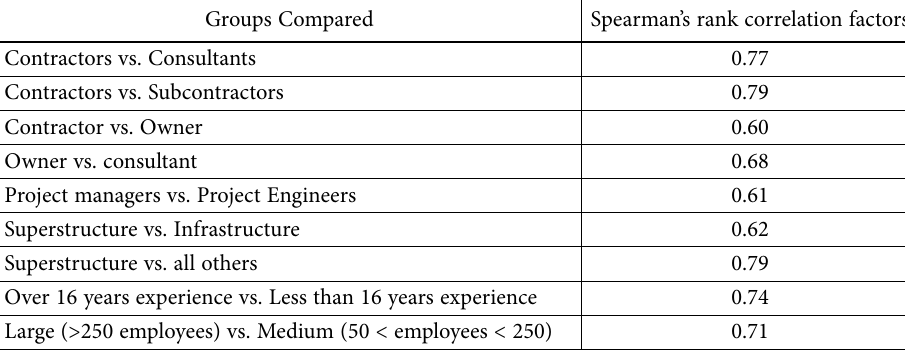
Table 3. Ranking comparison amongst